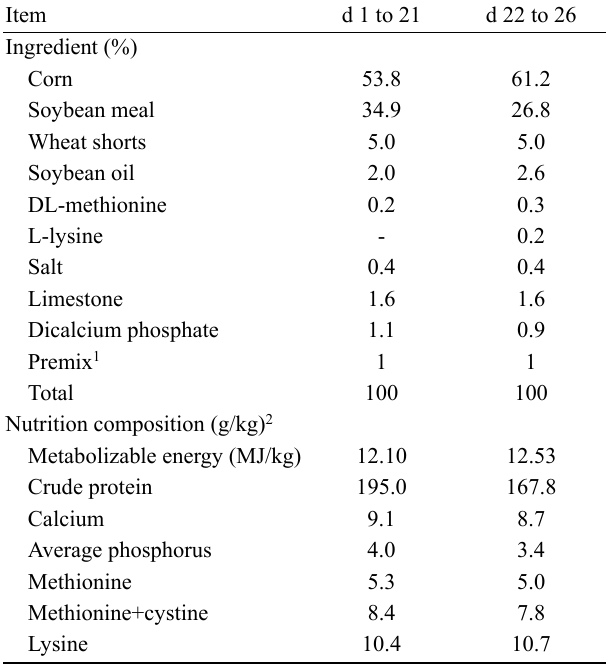
Table 1. Composition and nutrient level of basal